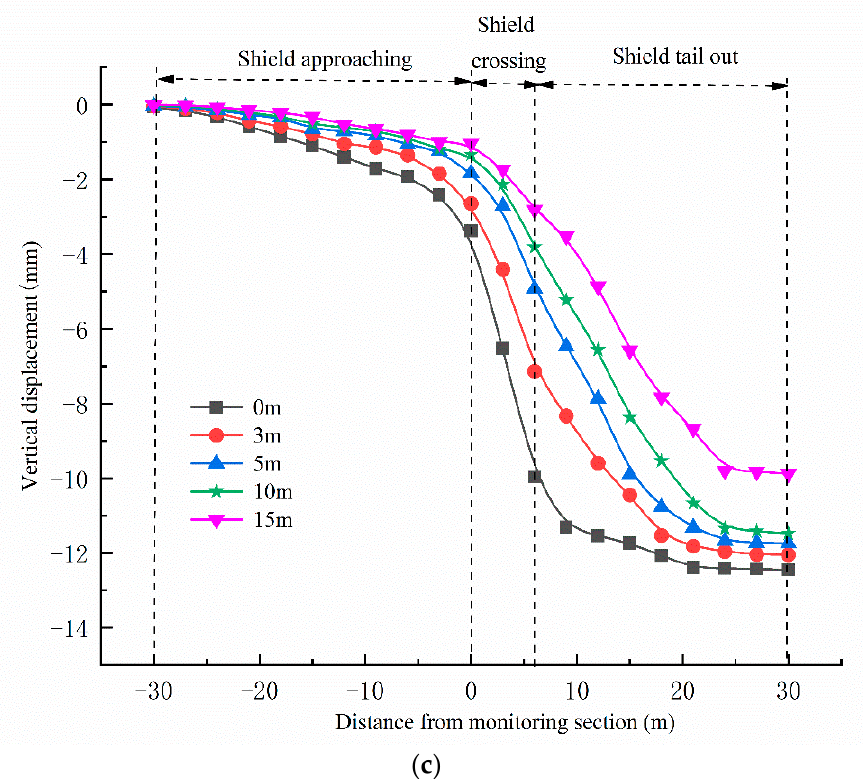
Figure 9. Layered subsidence time history curve of monitoring section stratum. ( a ) hole 1 #. ( b ) hole 2 #. ( c ) hole 3 #.